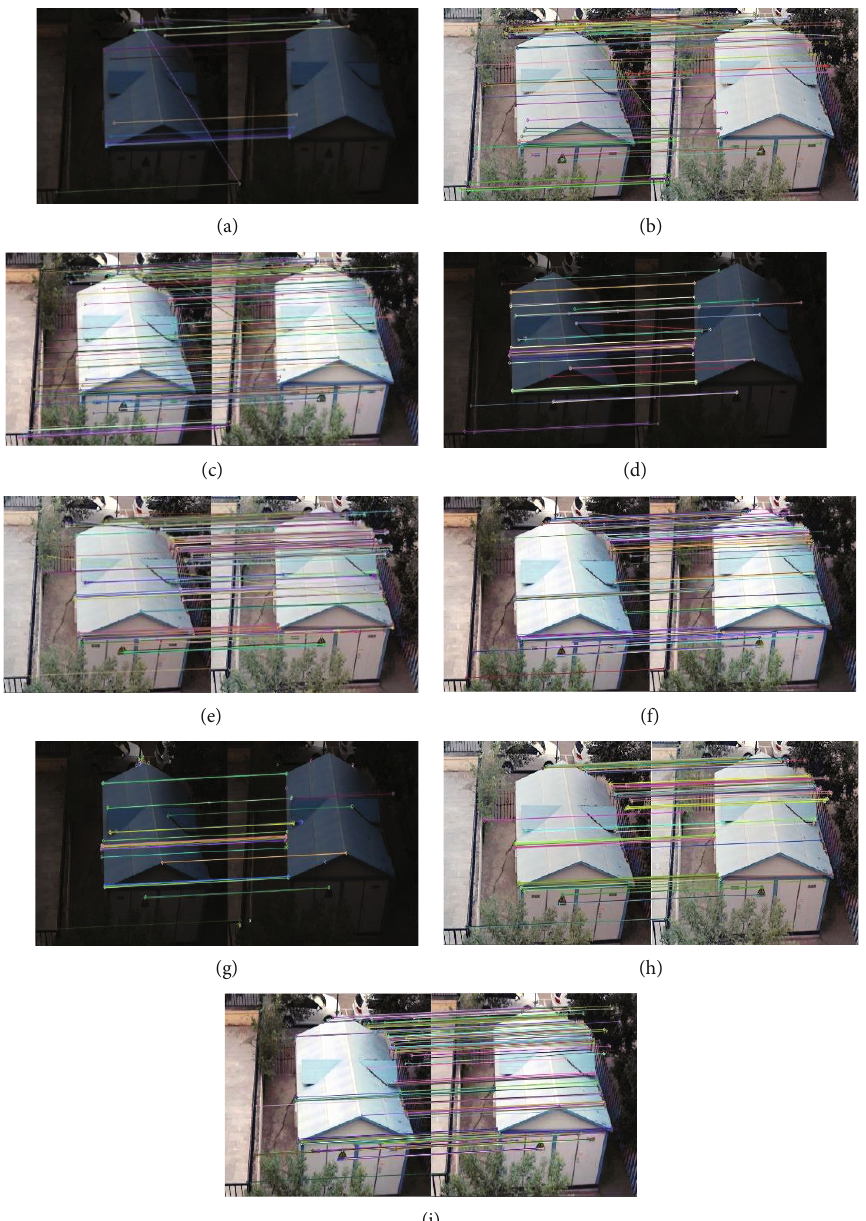
Figure 7: Scene 1: (a) SURF; (b) SURF+MSRCR; (c) SURF+Improved MSR; (d) ORB; (e) ORB+MSRCR; (f) ORB+Improved MSR; (g) ORB+PROSAC; (h) ORB+PROSAC+MSRCR; (i) method in this